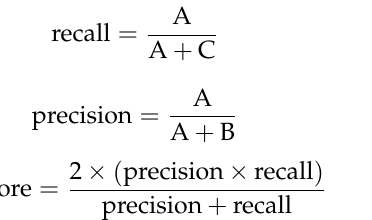
8 of 17 Table 3. Definitions of visibility ranges. Visibility Range Note A 10 to 20 km Good visibility (clear air) B 5 to 10 km Moderate visibility C 0 to 5 km